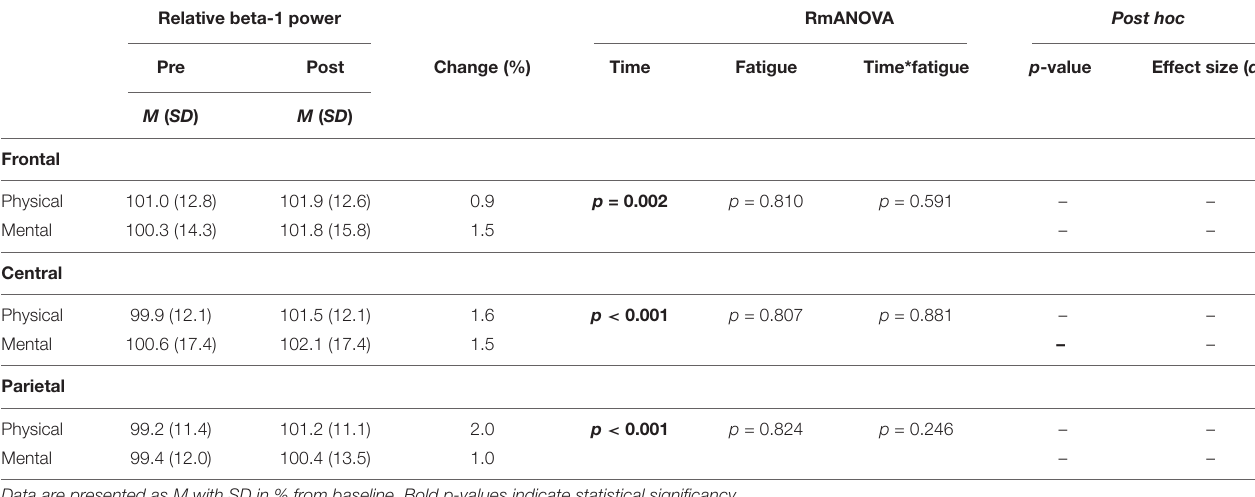
TABLE 5 | Averaged beta-1 frequency power relative to baseline values pre and post to PF and MF within the respective ROIs as well as rmANOVA results and post hoc tests. Relative beta-1 power